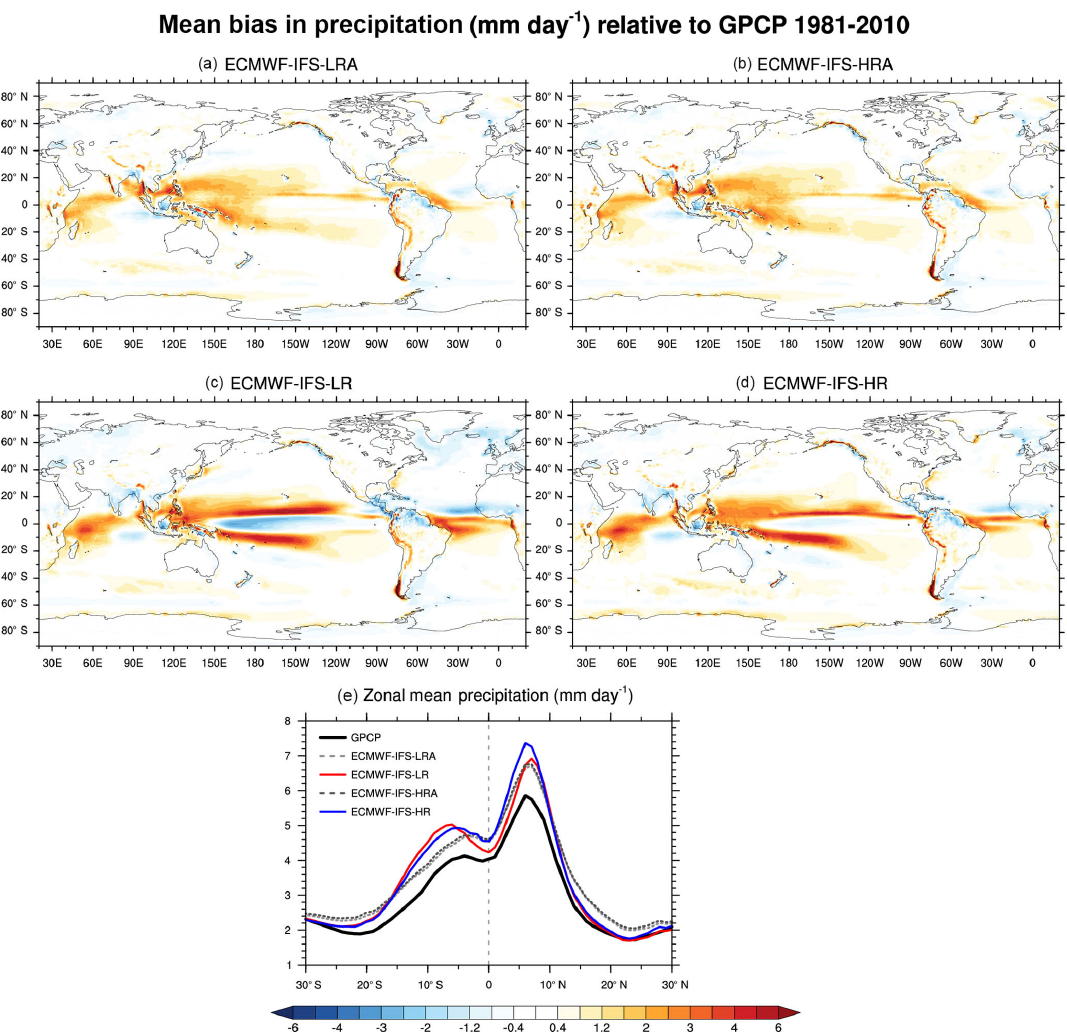
Figure 4. (a–d) Annual mean bias in total precipitation (mmday − 1 ) in (a–b) highresSST-present and (c–d) hist-1950 relative to the Global Precipitation Climatology Project data set v2.3 (GPCP; Adler et al., 2003) for the period 1981–2010. (e) Zonal mean of annual mean precipitation (mmday − 1 ) in highresSST-present, hist-1950, and the GPCP data